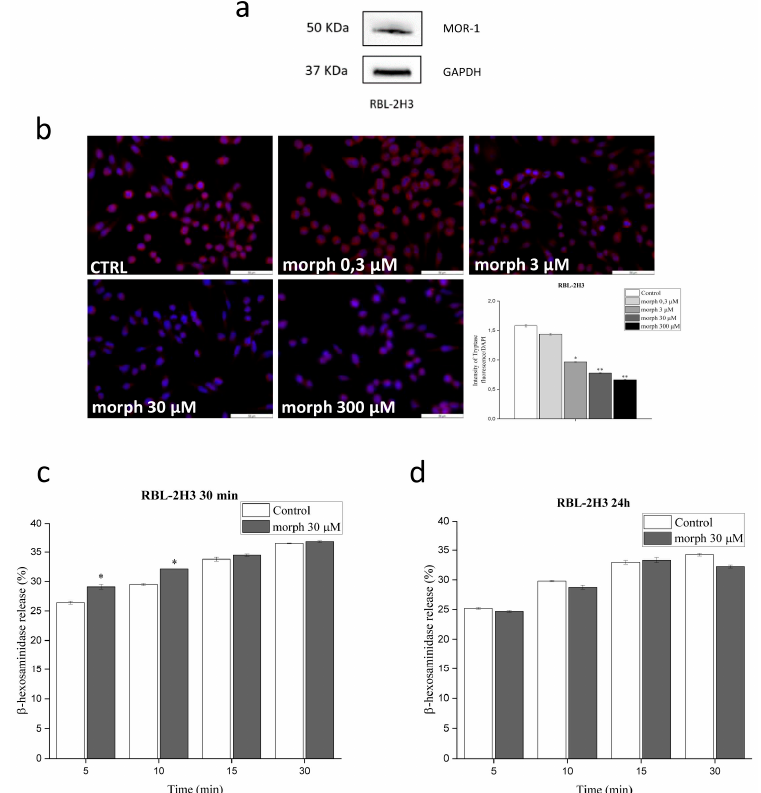
Figure 2. Effect of morphine on MC degranulation. ( a ) Western blot of MOR-1 ( µ -receptor) on RBL-2H3 cells. The expression was compared to GAPDH levels. ( b ) Immunofluorescence for tryptase on RBL-2H3 cells pre-sensitized with anti-DNP IgE 50 ng/mL, treated the next day with increasing concentrations of morphine (0.3–300 μ M) for 30 min and then stimulated with DNP-BSA for 10 min. Cell nuclei were labeled with DAPI. Scale bar = 50 μ m. ( c ) β -hexosaminidase assay of RBL-2H3 cells pre-sensitized with anti DNP-IgE 50 ng/mL, treated for 30 min with morphine 30 μ M and stimulated with DNP-BSA for 5, 10, 15, 30 min; ( d ) β -hexosaminidase assay of RBL-2H3 cells pre-sensitized with anti DNP-IgE 50 ng/mL, treated for 24 h with morphine 30 μ M and stimulated with DNP-BSA for 5, 10, 15, 30 min. DNP-BSA was used at a final concentration of 625 ng/mL in all experiments. Values are expressed as the mean ± S.E.M. of three experiments. * p < 0.05; ** p < 0.01 vs. control.